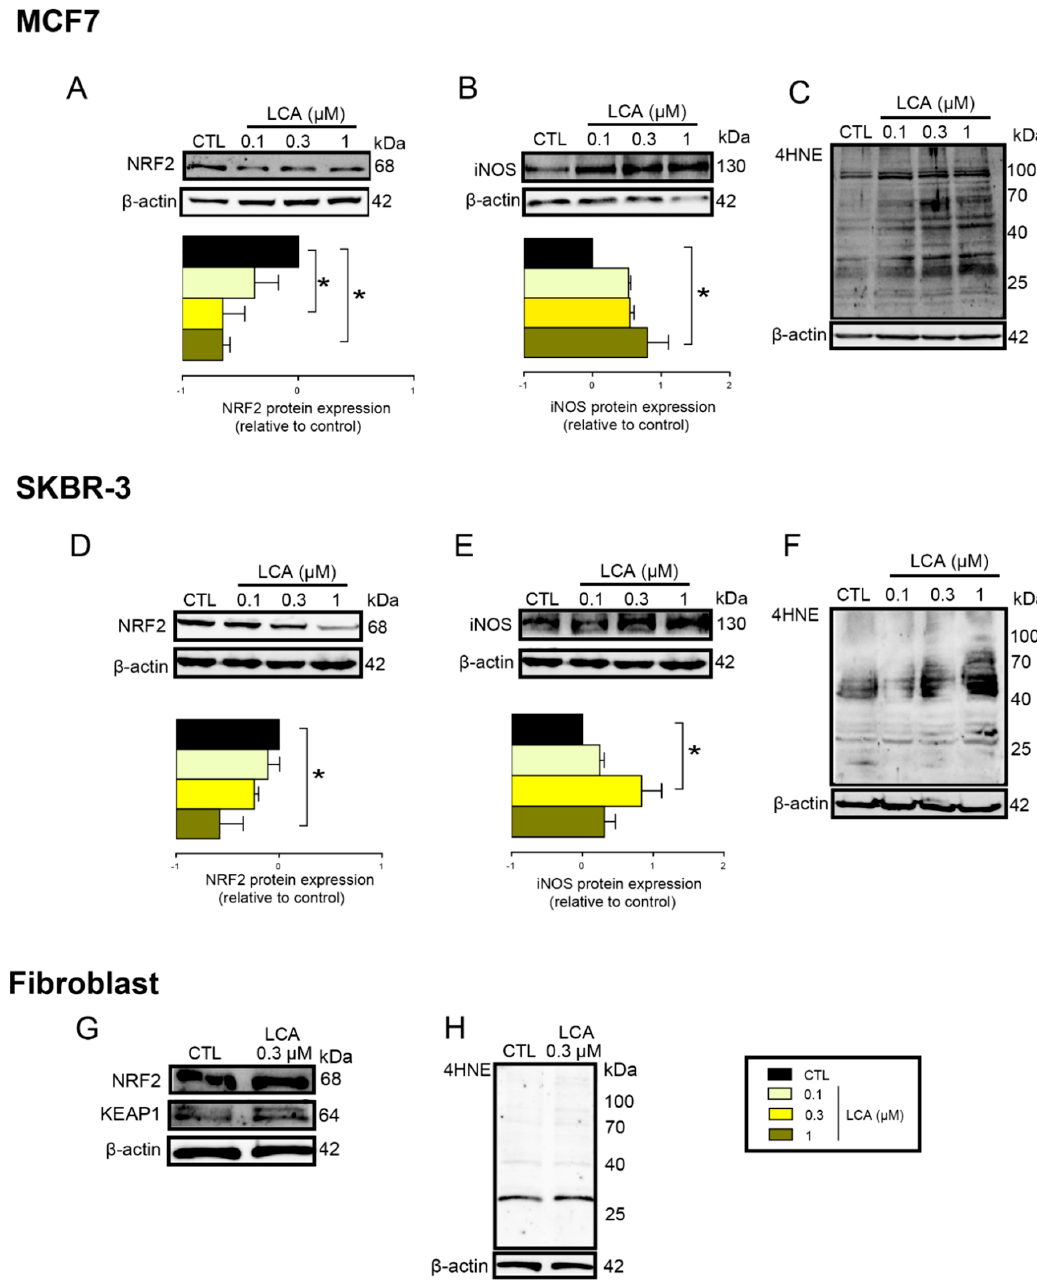
Figure 7. LCA induced oxidative stress in MCF7 and SKBR-3 human breast cancer cell lines, but not in primary fibroblasts. ( A – C ) The MCF7 cells were treated with LCA in the concentrations indicated for 48 h, then ( A ) NRF2, ( B ) iNOS protein expression, and ( C ) 4HNE were determined by western blotting ( n = 3). ( D – F ) The SKBR3 cells were treated with LCA for 48 h, then ( D ) NRF2, ( E ) iNOS, and (b) 4HNE expressions were determined by western blotting ( n = 3). Upper panels: representative figures. Lower panels: densitometric analysis of western blots. In the case of 4HNE, similar data were obtained in three independent experiments. ( G , H ) Fibroblast cells were treated with 0.3 µm LCA for 48 h then ( G ) NRF2, KEAP1, and ( H ) 4HNE expressions were determined by western blotting. Data are plotted as mean ± SEM. * p < 0.05, control vs. LCA-treated. (LCA, lithocholic acid; NRF2, nuclear factor, erythroid 2-like 2; 4HNE, 4-hydroxynonenal; iNOS, inducible nitric oxide